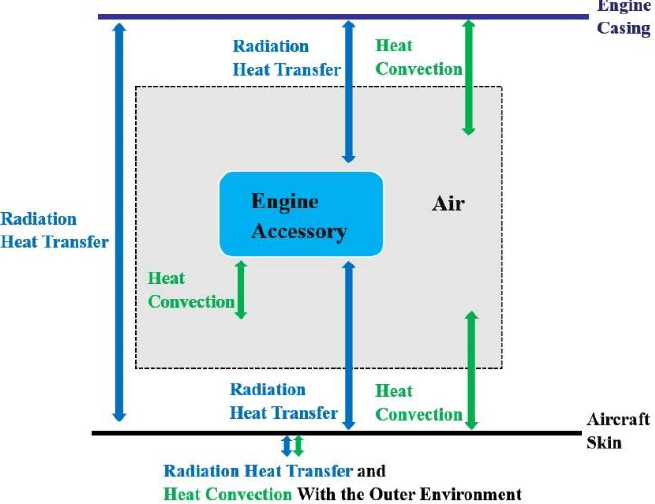
Figure 3. Heat transfer process analysis of various components in a TBCC engine cabin.